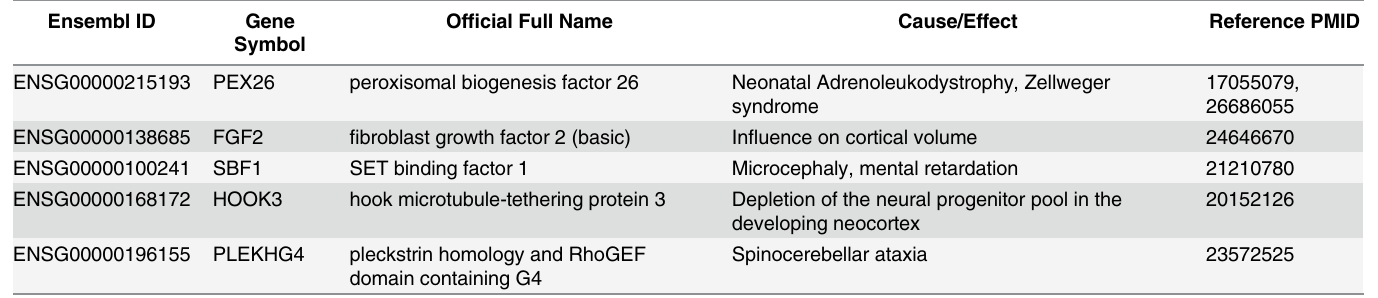
Table 1. Examples of human targeting-genes to ZIKV predicted miRNAs.